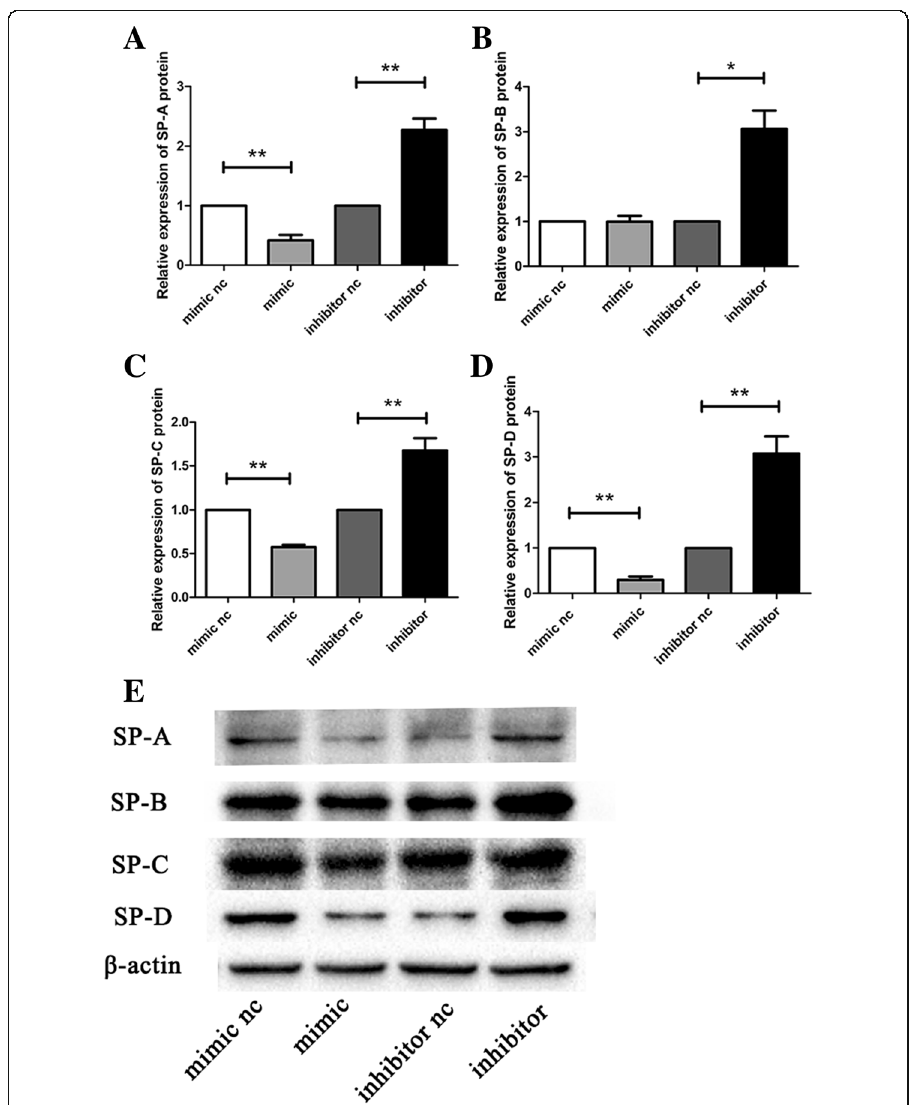
Fig. 7 Western blotting is used to detect the protein expression of surfactant proteins. a – Relative expression of SP-A protein. b – Relative expression of SP-B protein. c – Relative expression of SP-C protein. d – Relative expression of SP-D protein. e – Western blotting results for, from left to right: mimic nc, mimic, inhibitor nc, inhibitor. * p < 0.05; ** p < 0.01; *** p < 0.001 vs. miR-431-5p negative